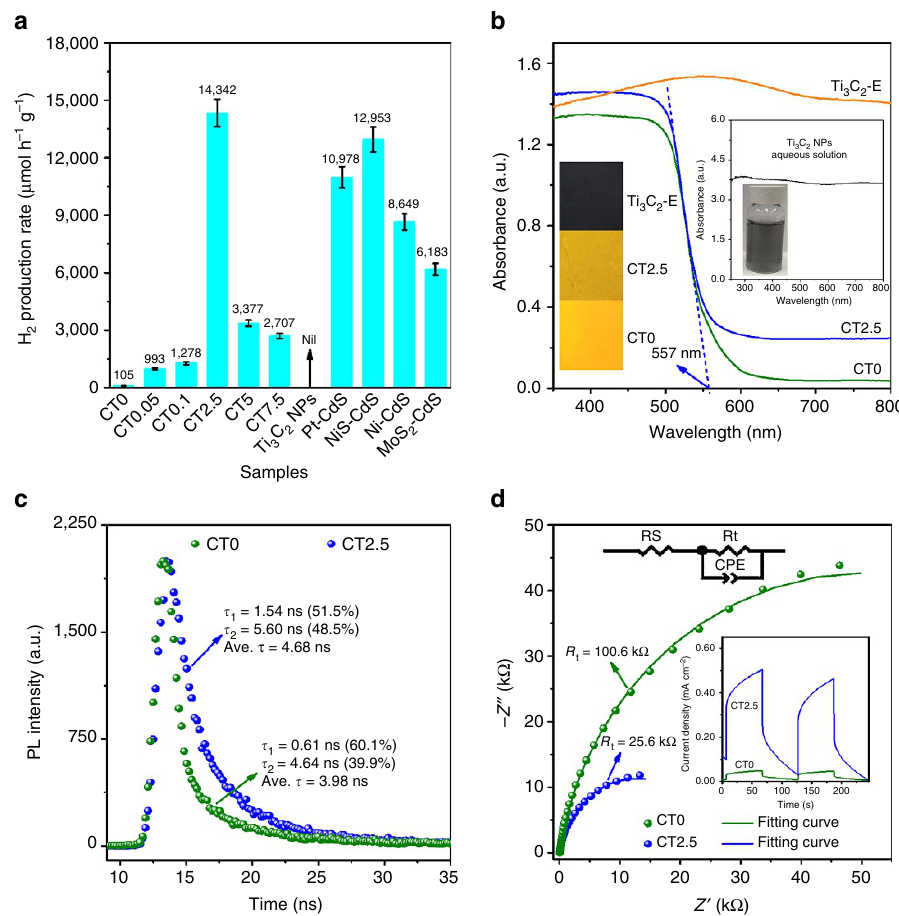
Figure 3 | Photocatalytic performance and spectroscopy/(photo)electrochemical characterization. ( a ) A comparison of the photocatalytic H 2 -production activities of CT0, CT0.05, CT0.1, CT2.5, CT5, CT7.5, Ti 3 C 2 NPs, Pt–CdS, NiS–CdS, Ni–CdS and MoS 2 –CdS. The error bars are defined as s.d. ( b ) Ultraviolet-visible diffuse reflectance spectra of CT0, CT2.5 and Ti 3 C 2 -E. The insets show the colours of all the samples as well as the ultraviolet-visible absorbance spectrum and picture of the Ti 3 C 2 NPs aqueous solution. ( c ) Time-resolved PL spectra of CT0 and CT2.5. ( d ) EIS Nyquist plots of CT0 and CT2.5 electrodes measured under the open-circle potential and visible-light irradiation in 0.5M potassium phosphate buffer (pH ¼ 7) solution. The inset shows the transient photocurrent responses of CT0 and CT2.5 electrodes in 0.2M Na 2 S þ 0.04M Na 2 SO 3 mixed aqueous solution under visible-light Supplementary Fig. 15b) between the original and used CT2.5 (CT2.5-A) shows no apparent alterations in CT2.5-A, which is in accordance to its repeated high activity.